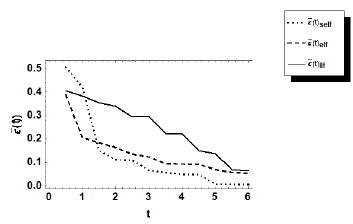
Figure 1 – When c = 1 and h = 1, the MSE of (cid:69) ( t ) using Lindley approxima- tion method.